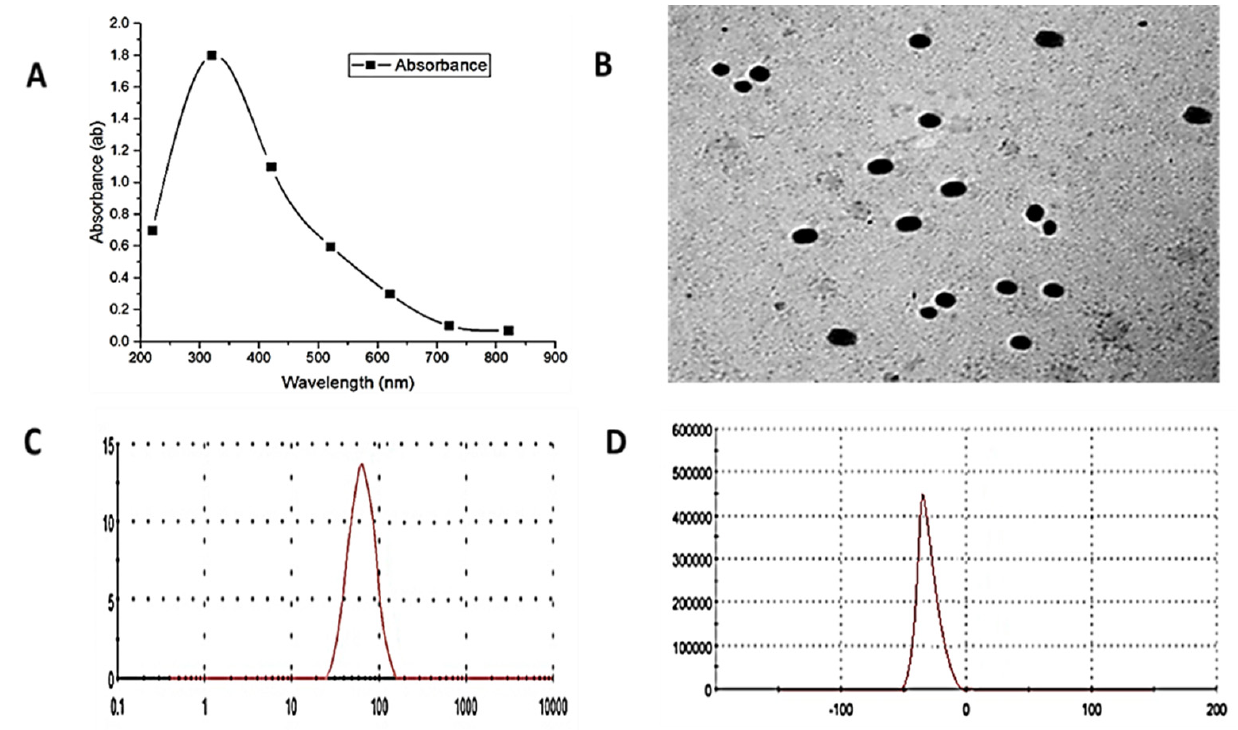
Figure 1. ZnO-NPs characterization: ( A ) shows the UV–VIS spectroscopy analysis of ZnO-NPs to estimate their optical properties; the maximum peak was 340 nm. ( B ) The size and shape of the ZnO-NPs were spherical with an average size of 108 nm by TEM. ( C ) DLS analysis showed that the exact size was 89 nm. ( D ) Zeta potential analysis showed that the net surface charge of ZnO-NPs was − 33 mV.